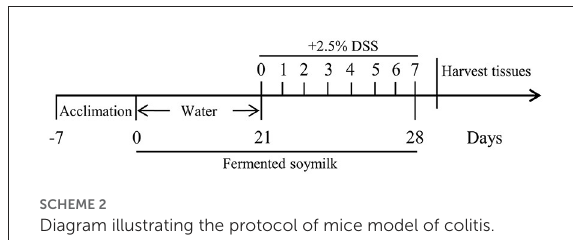
SCHEME2 Diagram illustrating the protocol of mice model of